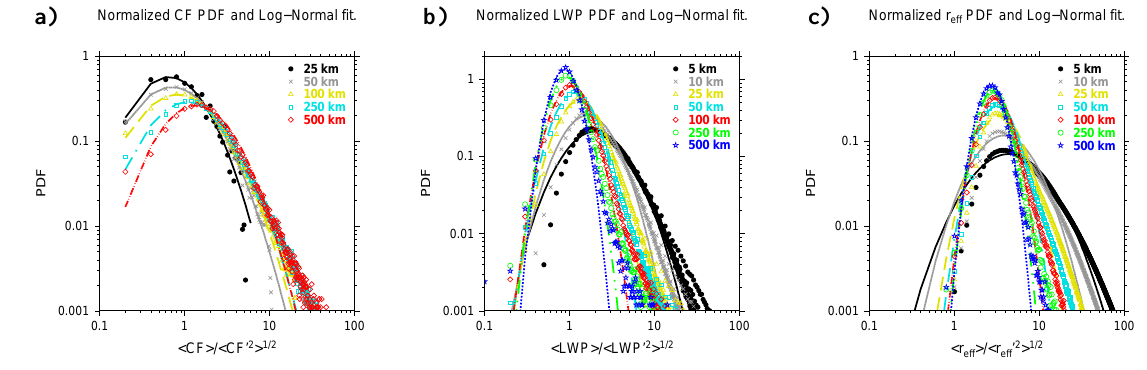
Fig. 4. A different look into cloud property PDFs: means normalized by standard deviations as a function of scale.